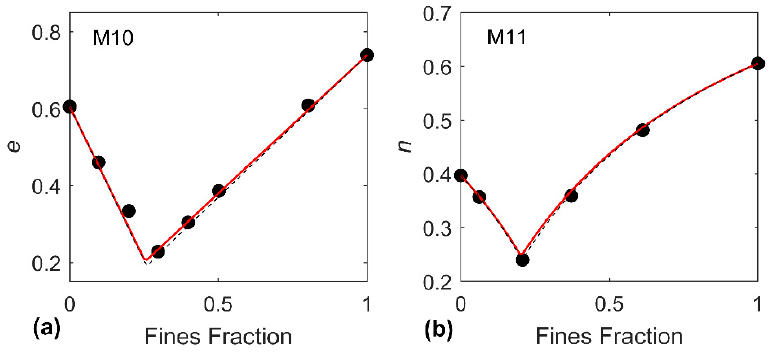
Figure 4. Porosity, n , (or void ratio, e ) as function of fines fraction for mixtures ( a ) M10 and ( b ) M11. Prediction of ideal packing model is shown in dashed curve while the current model ( p = 0.15) is shown in solid red curve.